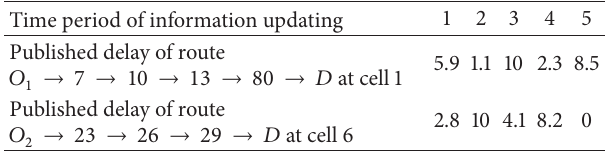
Table 3: Proactive traffic information solution/mins.